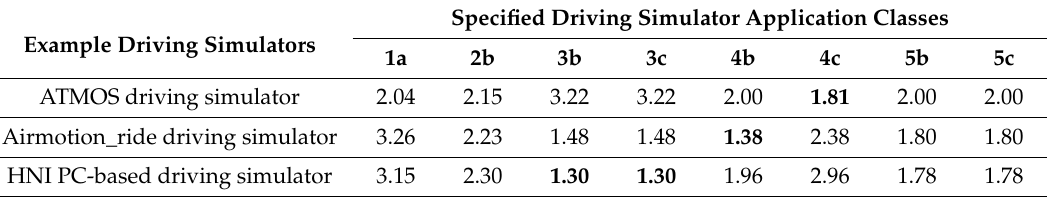
Table 12. Results of the developed cost function for three example driving